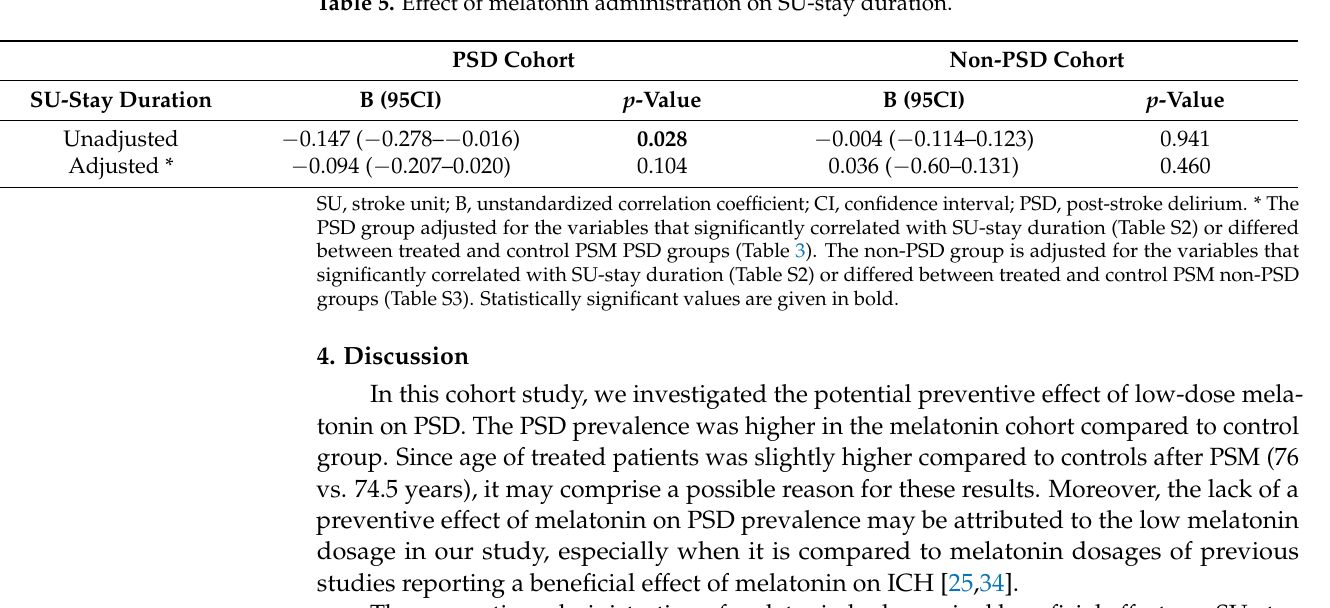
Table 5. Effect of melatonin administration on SU-stay duration.